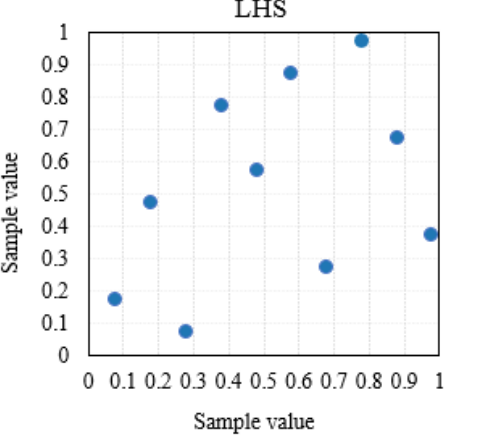
Table 3. Structural and material properties of the building envelope.